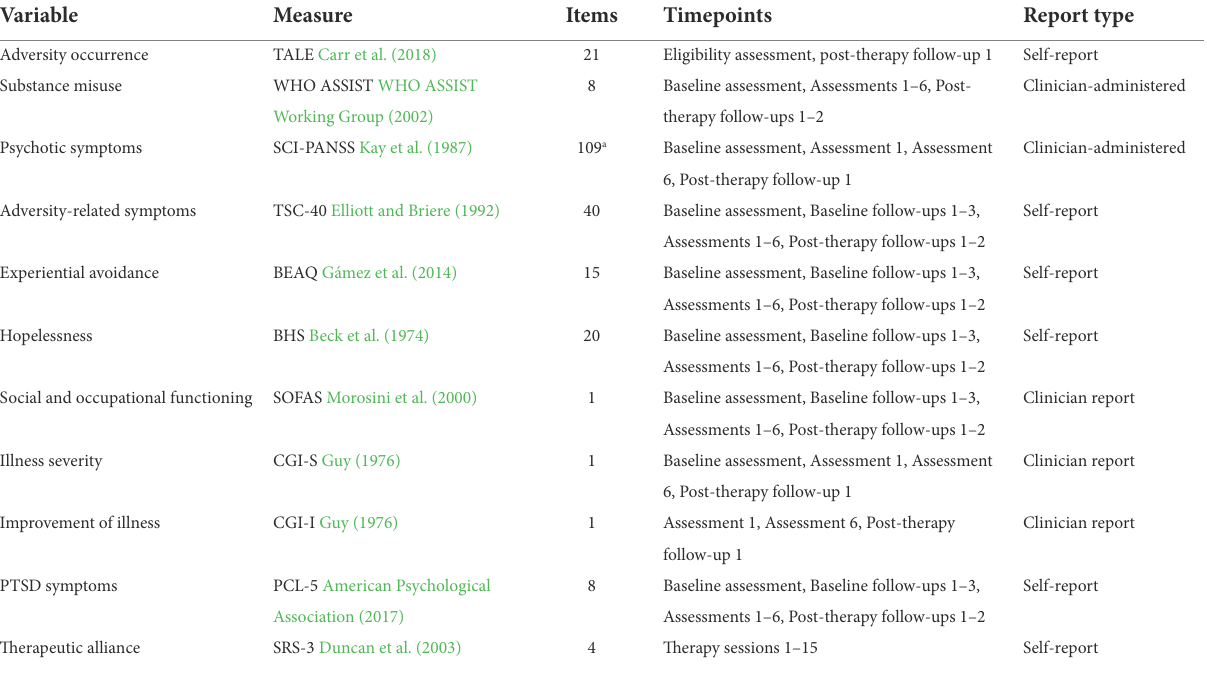
TABLE 1 Measures for PE+